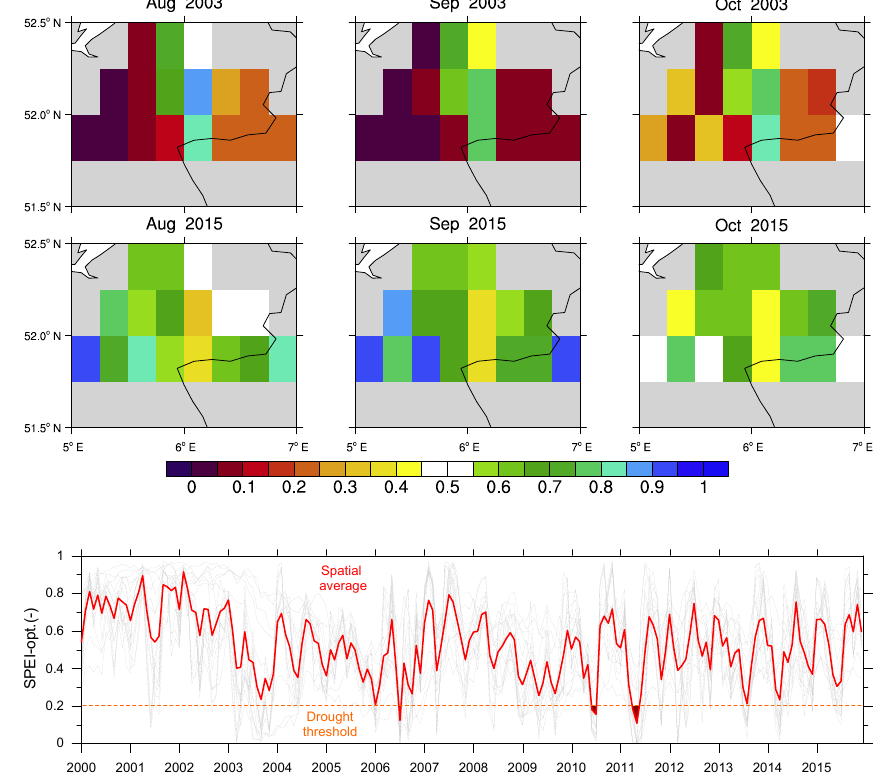
Figure 7. Same as Fig. 6 but for the central Netherlands study